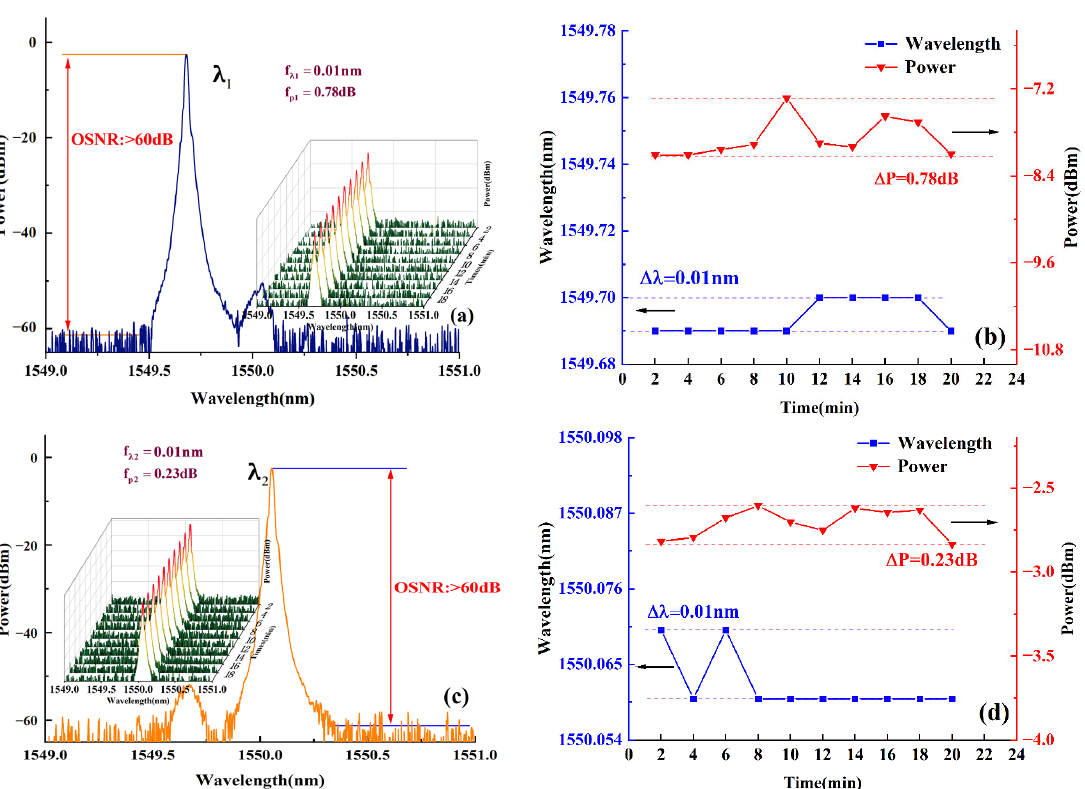
Figure 6. Optical spectrum and stability performance of single ‐ wavelength lasing. ( a , b ) Typical spectrum and wavelength stability at λ 1 ; ( c , d ) typical spectrum and wavelength stability at λ 2 . Additionally, when the axial strain was applied to the PMFBG fixed on the optical fiber’s displacement platform, its central wavelength (with a 3 dB bandwidth of 0.22 nm) drifted from about 1549 nm to 1551 nm, ensuring that the central wavelength of the trans ‐ mission channel coincided with the central wavelength of the reflection channel during the tuning process of applying stress, which is an advantageous position in the gain com ‐ petition. As shown in Figure 7, the dual ‐ wavelength interval was maintained between 0.36 and 0.37 nm, and the tunable range was 0.17 nm, which basically corresponded to the interval range of the narrow ‐ band transmission peak.